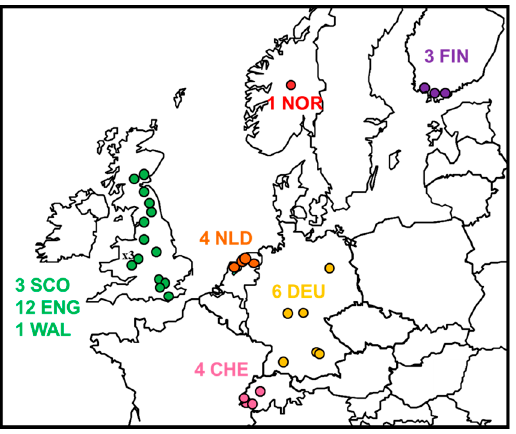
Figure 1. Distribution of 34 confirmed cases of EBLV-2 (Table 1) in Europe between 1985 and 2017 (WHO Rabies Bulletin Europe).